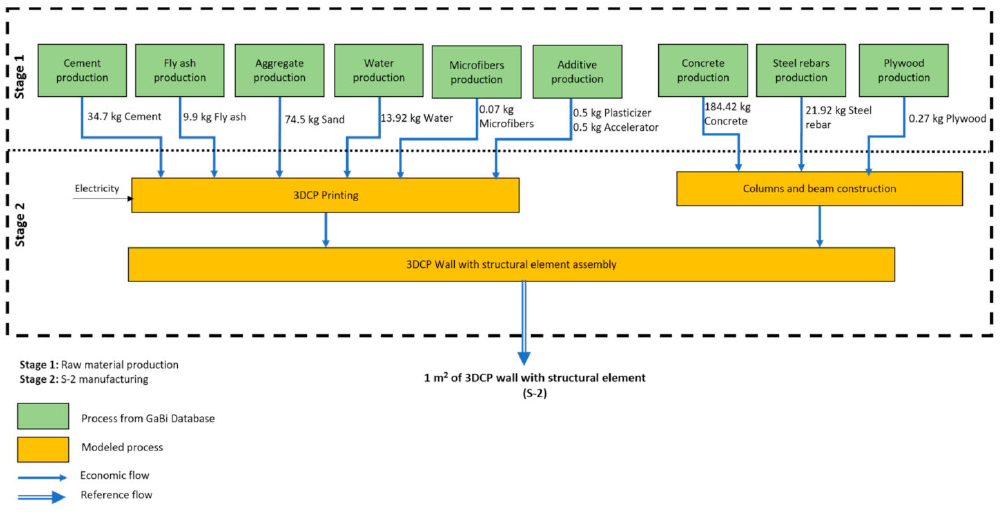
Figure 5. Flowchart of S-2. Table 2. Material inventory for S-1 and